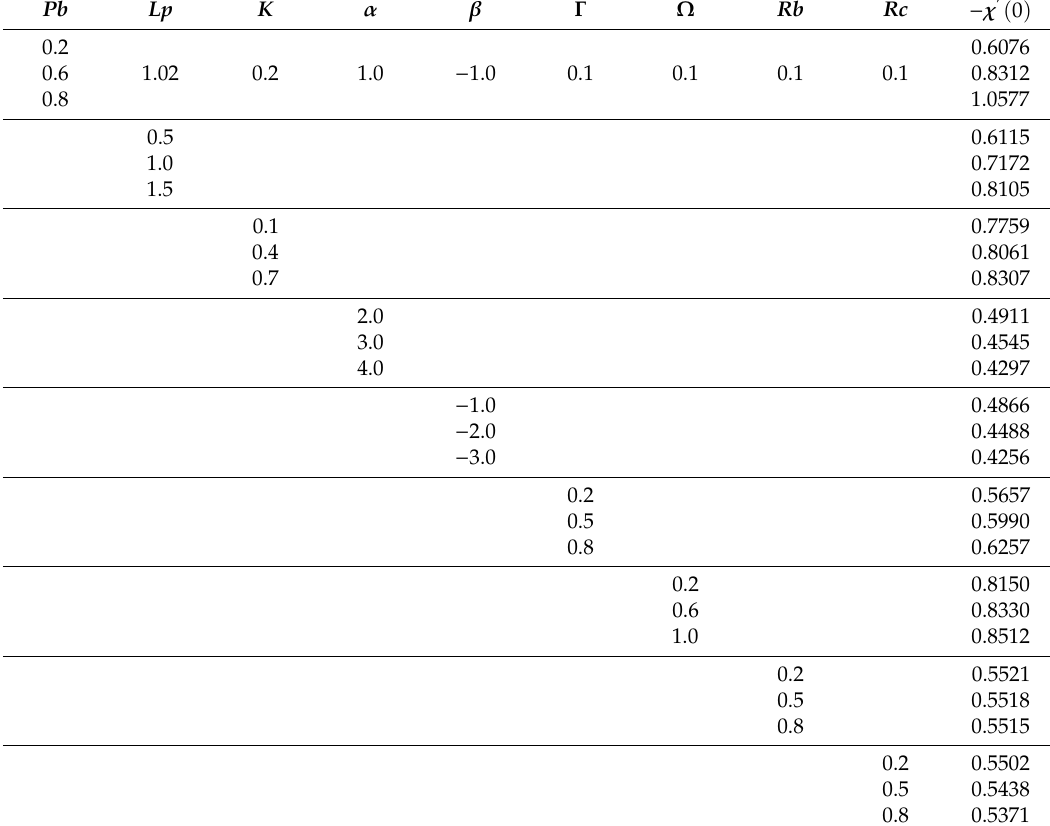
Table 5. Variation of motile density number − χ (cid:48) ( 0 ) for of Pb , Lp , K , α , β , Γ , Ω , Rb and Rc